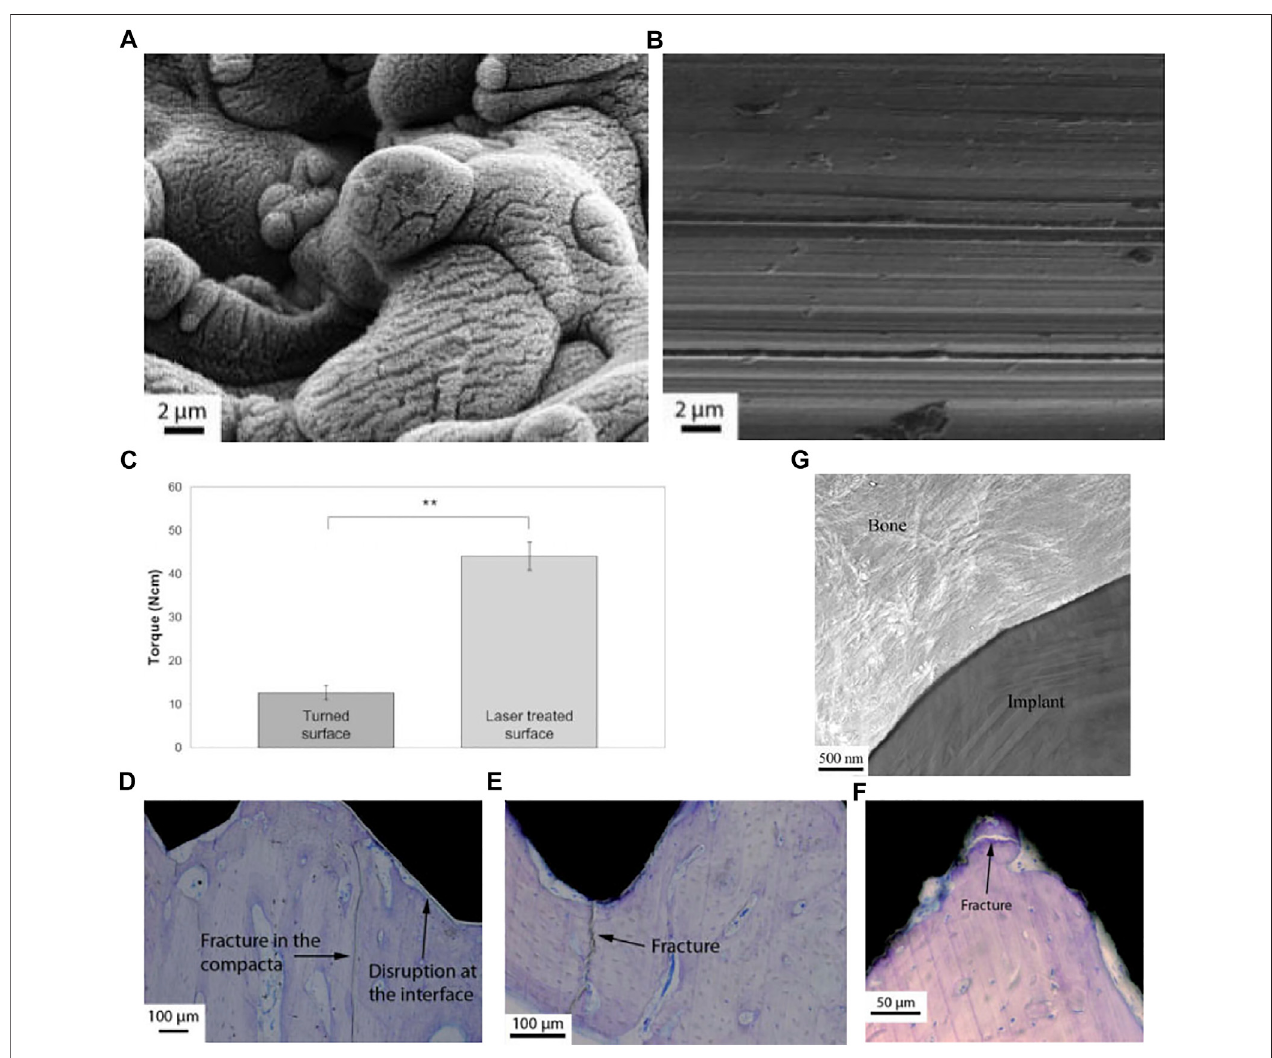
FIGURE 4 | (A,B) SEM images of laser-treated surface (left) and machined surface (right). (C – F) Biomechanical torsional evaluation results of machined titanium (C – E) and laser-treated titanium (C,F) . (E) TEM image of the laser-treated implant-bone interface. Reprinted with permission from (Palmquist et al., 2010).